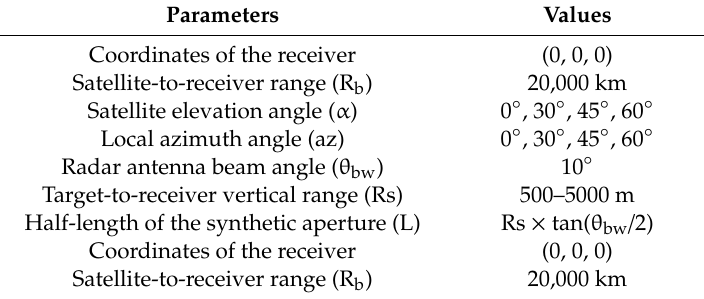
Table 1. Parameters for the real bistatic range and the approximate bistatic range